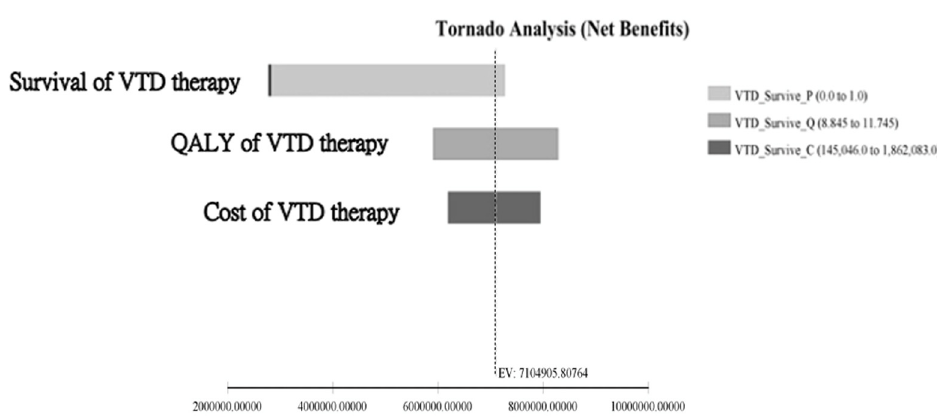
Figure 5. Tornado analysis of the benefit.